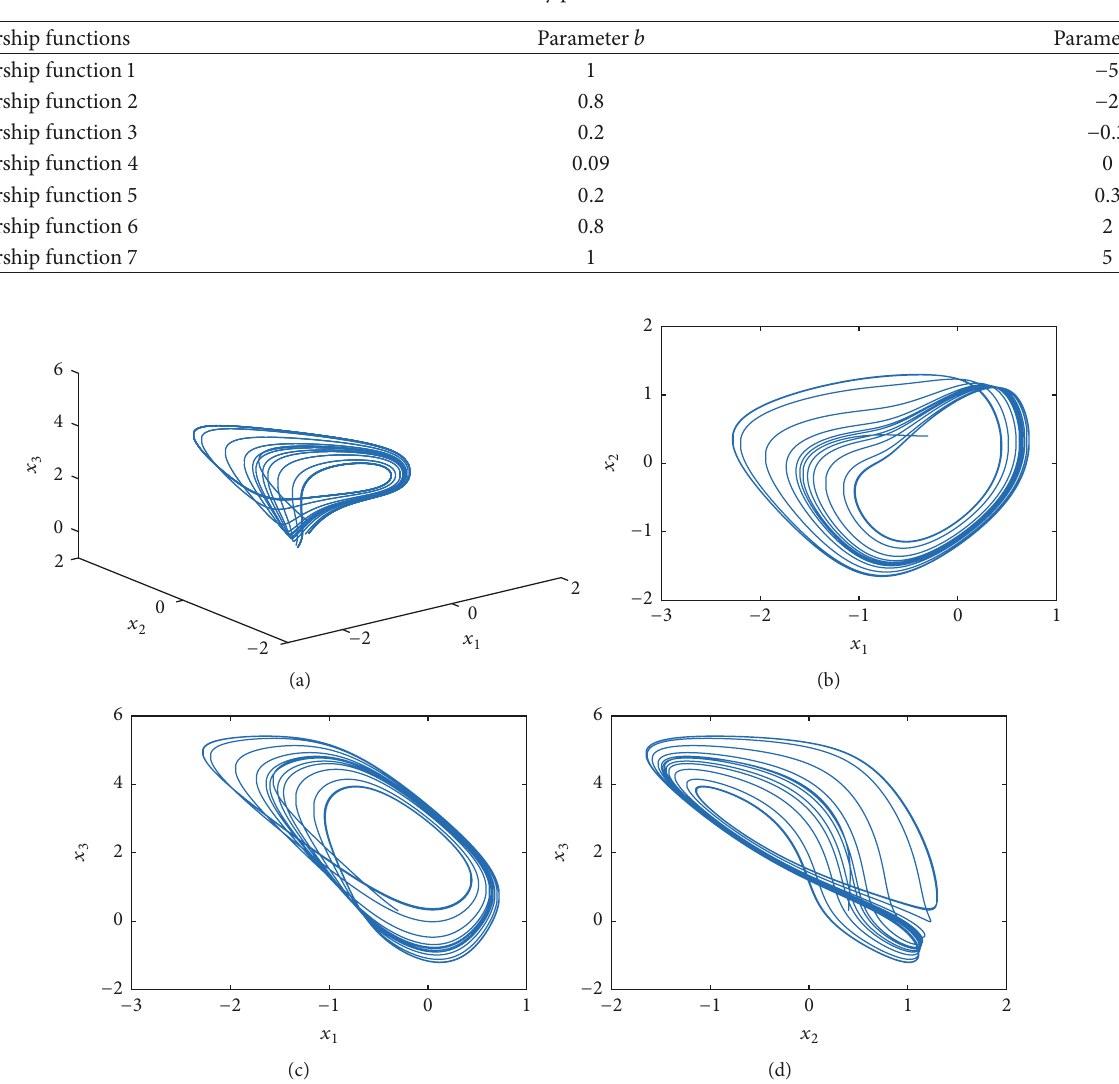
Figure 2: Chaotic dynamic of the FONN (19) in (a) 3D space; (b) 𝑥 1 - 𝑥 2 plane; (c) 𝑥 1 - 𝑥 3 plane; (d) 𝑥 2 - 𝑥 3 plane.